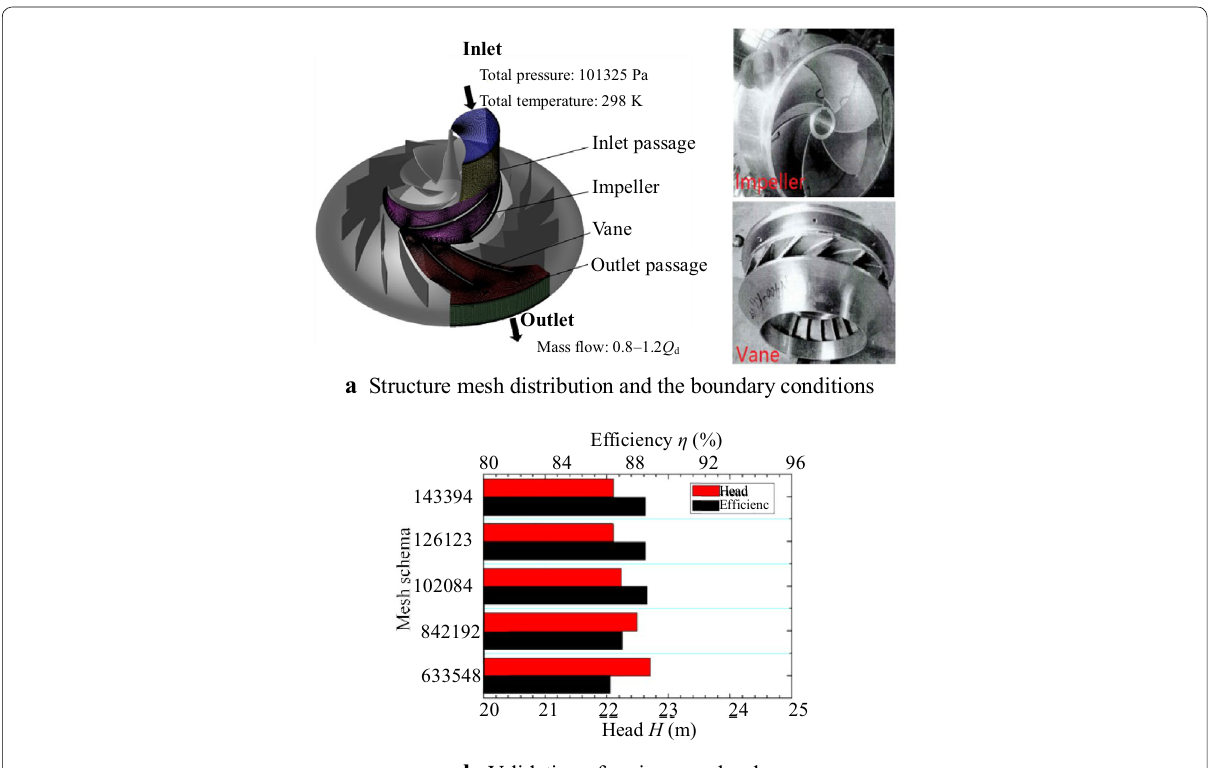
Figure 6 Introduction of the target canned nuclear